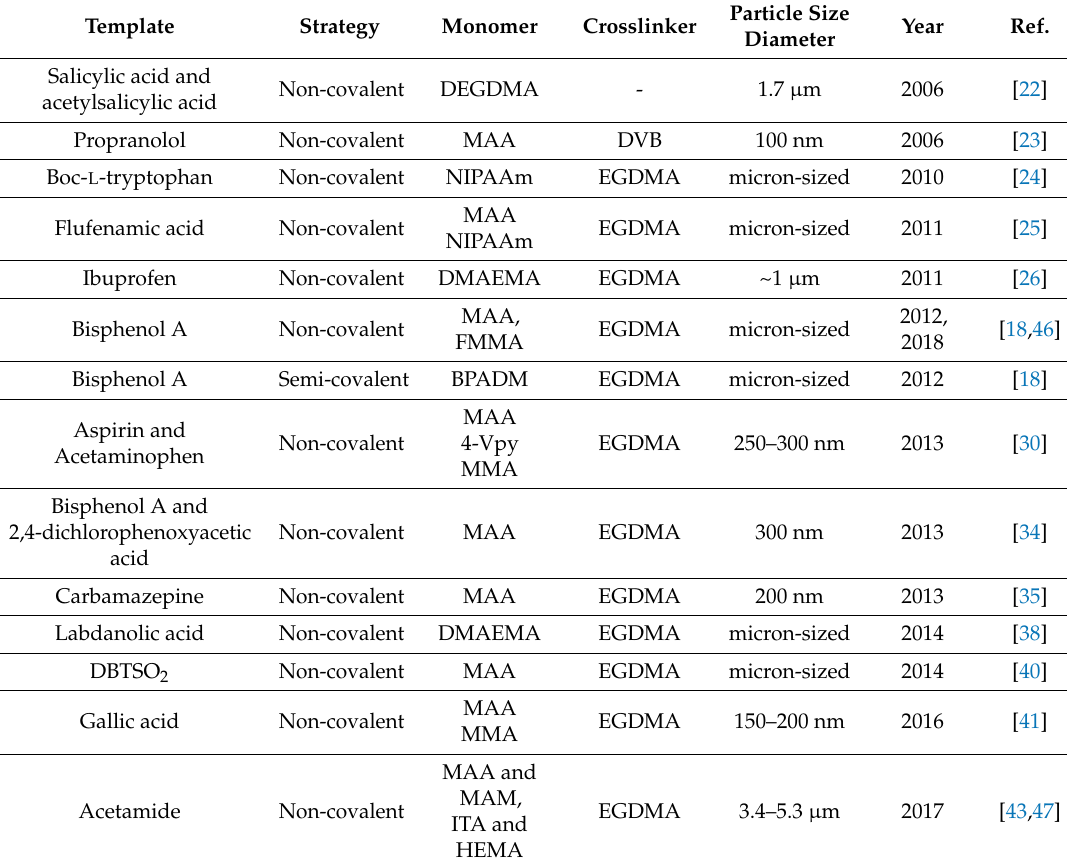
Table 1. Molecularly imprinted polymer (MIP) synthesis in supercritical carbon dioxide (scCO 2 ).